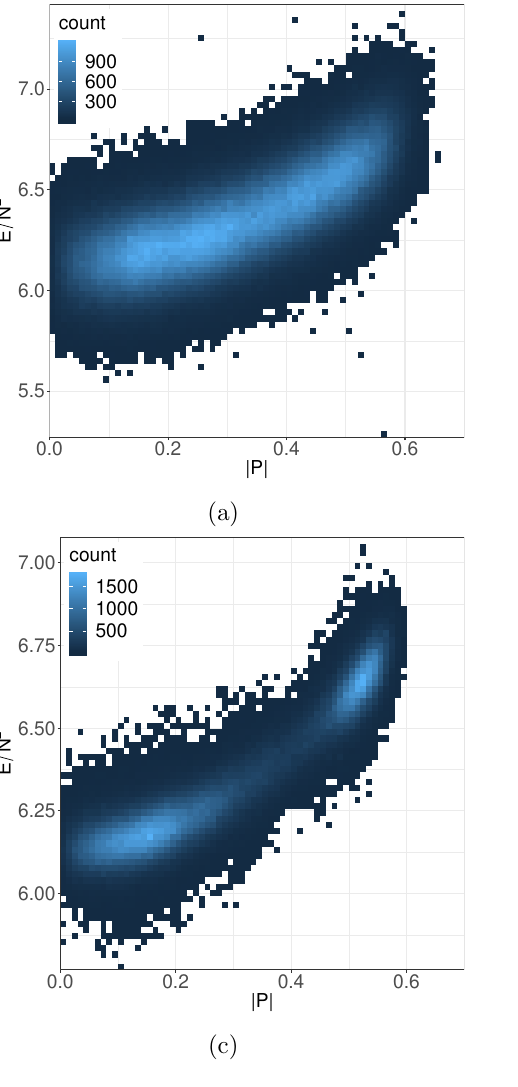
Figure 16. (a-c) Correlations of E=N 2 and j P j for L = 24, N = 32 ; 48 ; 64 at T = 0 : 883 ; 0 : 885 ; 0 : 885. d) Correlations of R 2 and j P j for L = 24, N = 64 at T = 0 :